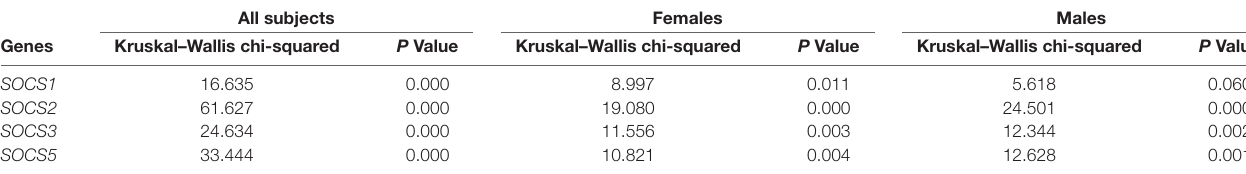
TABLE 1 | Relative expressions of SOCS genes in patients compared with controls (RME: ratio of mean expression). All subjects Females Males